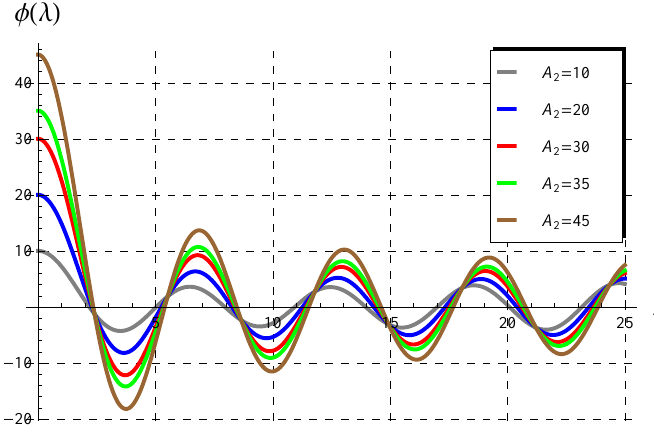
Figure 3. Behavior of φ ( λ ) vs. λ in the range 10 ≤ A 2 < 50.